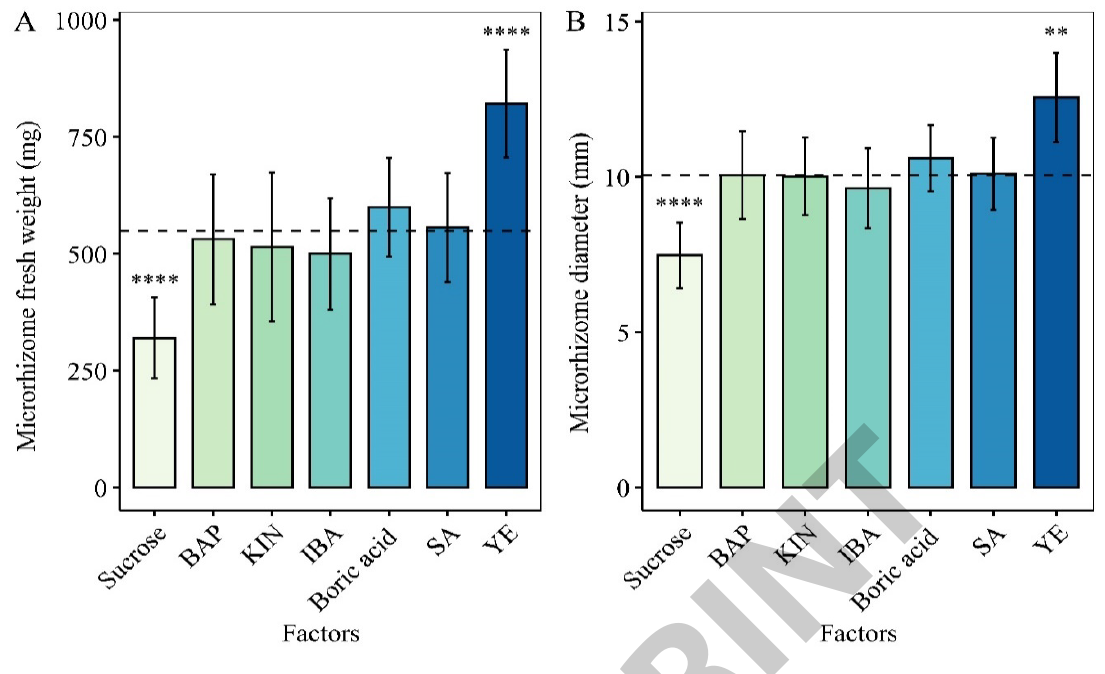
Figure 3. Bar graphs showing Hotelling’s T 2 test results for microrhizome fresh weight (A) and diameter (B) grown on medium with 80 g/L sucrose, 1 mg/L BAP, 1 mg/L KIN, 2 mg/L IBA, 248 mg/L H 3 BO 3 , 50 µM SA, and 0.5 mg/L YE. The mean microrhizome fresh weight and diameter of 80 g/L sucrose and 0.5 mg/L YE are significantly different from those of the pooled group (**** p < 0.0001, ** p < 0.01). YE at a concentration of 0.5 mg/L stimulated the formation of the largest and heaviest microrhizome. Error bars are 95% CI of mean (mean ± t (49) × SE, where t (49) is the upper 0.025 critical value for the t distribution with 49 degrees of freedom). The dashed lines represent the pooled group’s mean values (548.98 mg and 10.07 mm, for fresh weight and